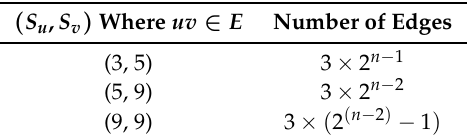
Table 2. Edge partition of Γ 2 n on the basis of degree sum of neighbors of end vertices of each edge.